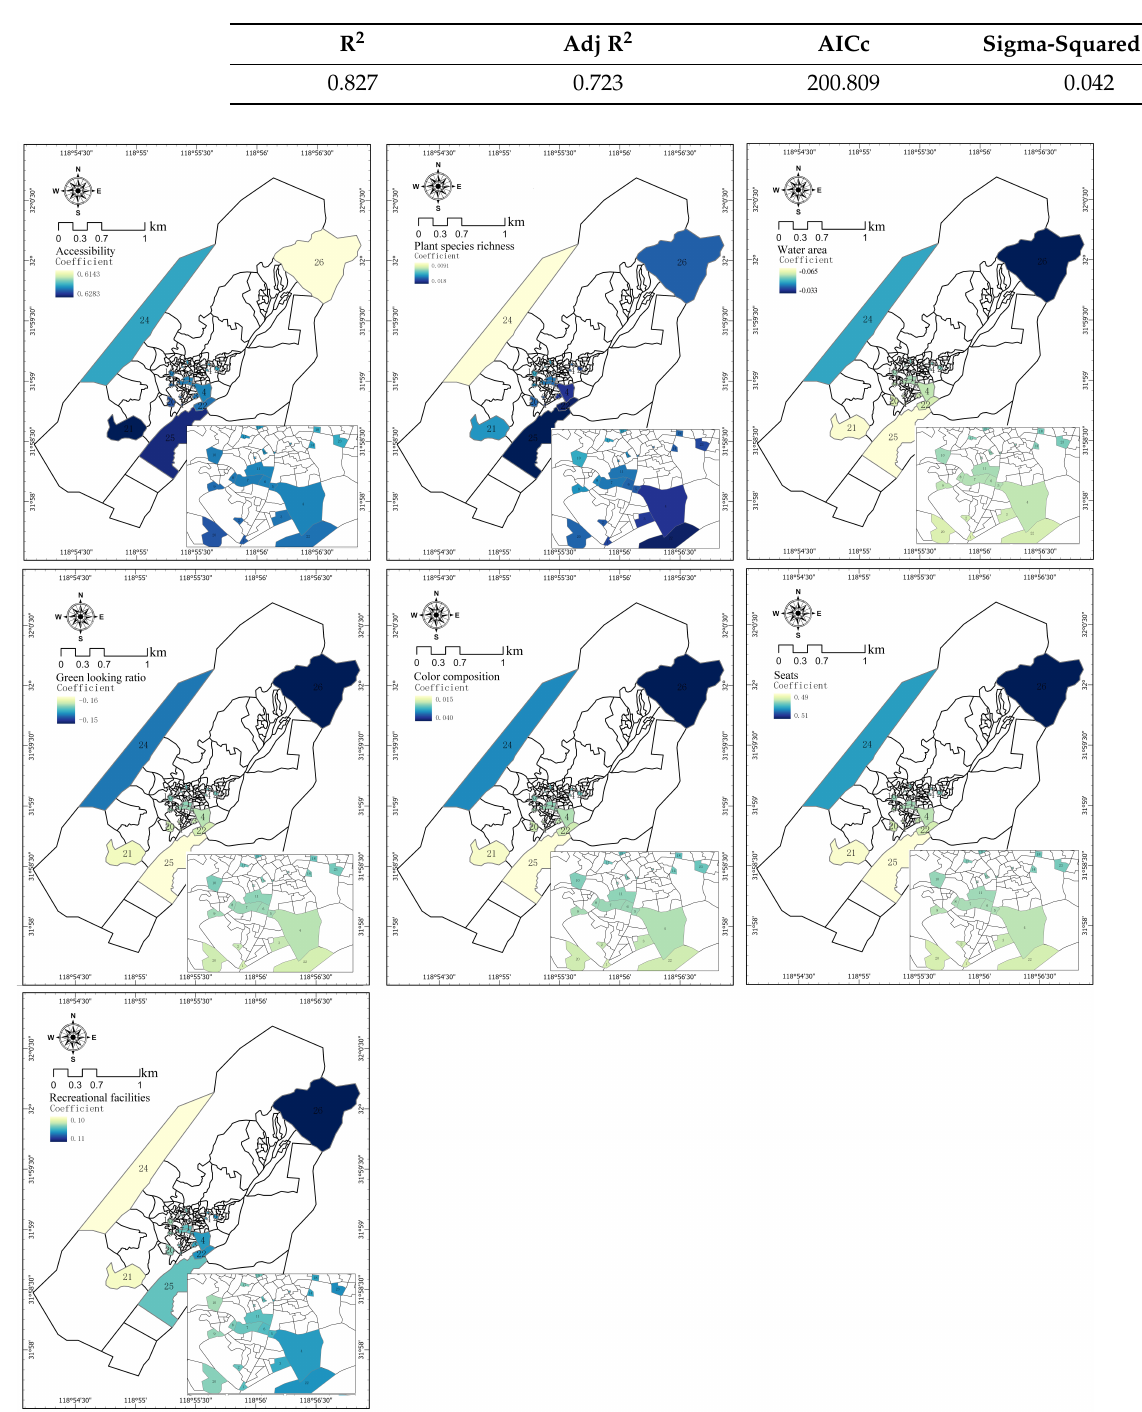
Table 5. Calculation Results of GWR Model—Tourists.